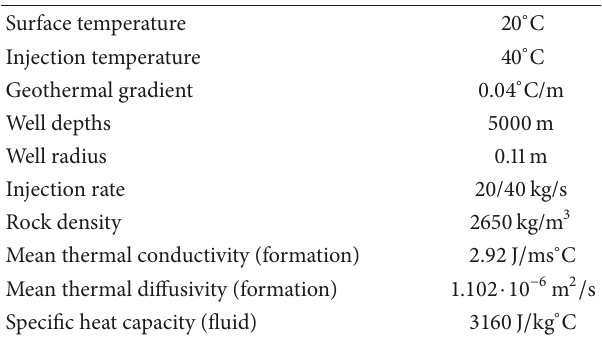
Table 1: Properties used in estimation of well temperature